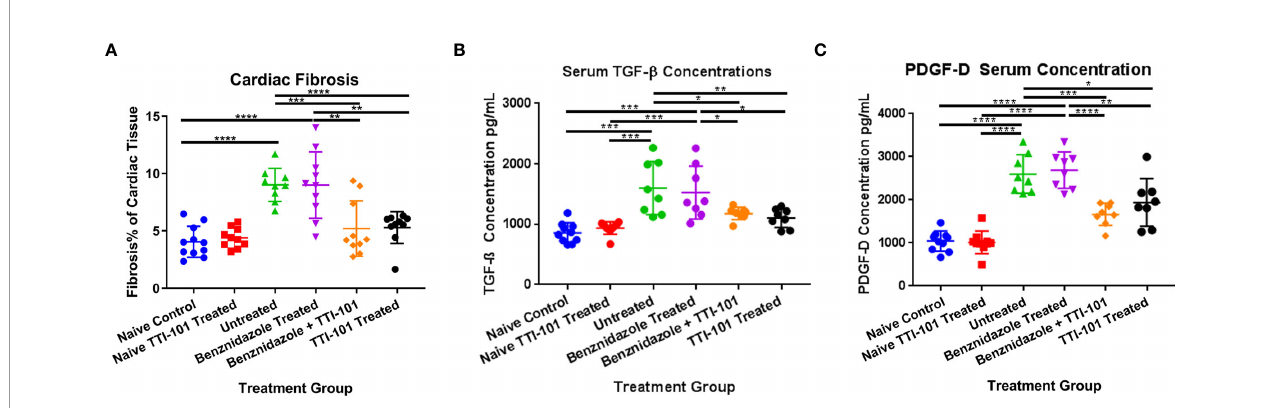
FIGURE 4 | Cardiac fi brosis and fi brosis biomarkers in experimental animals. Relative fi brosis % of total cardiac tissue imaged is illustrated for 91 days post infection (DPI) at conclusion of treatment (A) . Terminal serum from all animals was collected at the conclusion of treatment at 91 DPI. Biomarkers of cardiac fi brosis were measured by ELISA. Serum concentrations of transforming growth factor beta (TGF- b ) (B) and platelet-derived growth factor (PDGF)-D (C) at 91 DPI are shown. Representative images from one of two replicate experiments are shown. Error bars represent SD. Data were analyzed with Student ’ s t-test; *p < 0.05, **p < 0.01, ***p < 0.001, ****p <